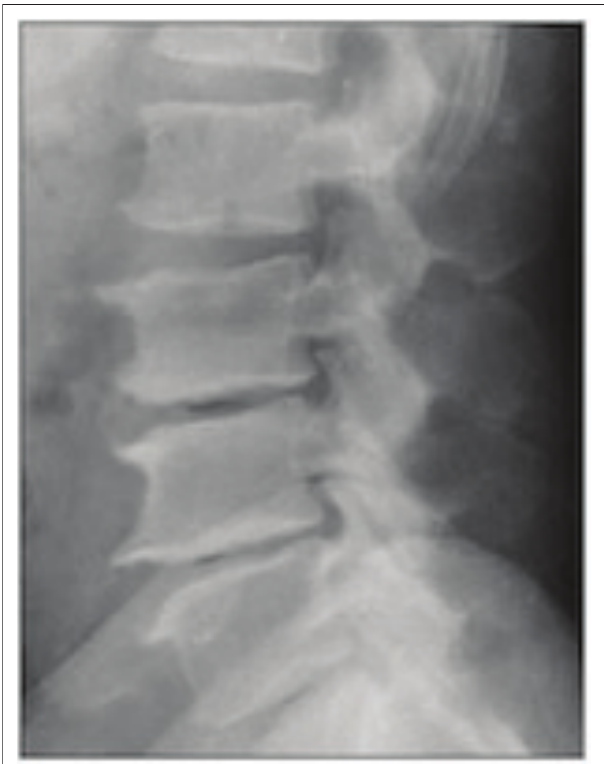
FIGURE 3: X-ray image for objectively structured clinical examination